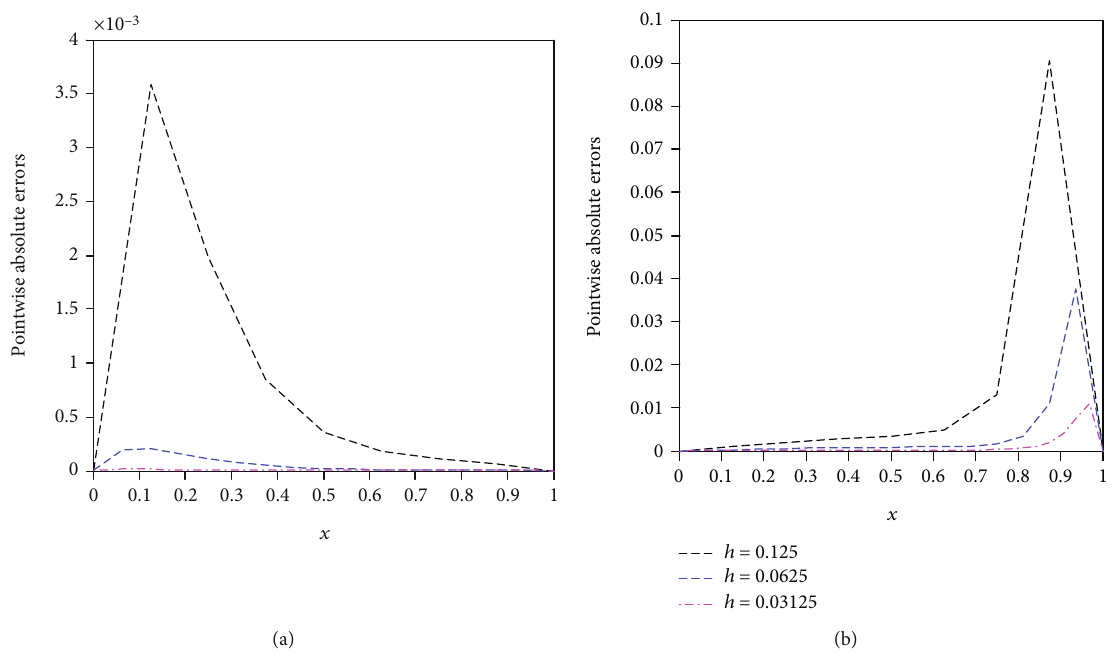
Figure 3: Pointwise absolute errors of Examples 6 and 7, respectively, for ε = 0 : 1 and δ , η = 0 : 5 ε . Table 1: Rate of convergence for ε = 0 : 1, η = 0 : 5 ε